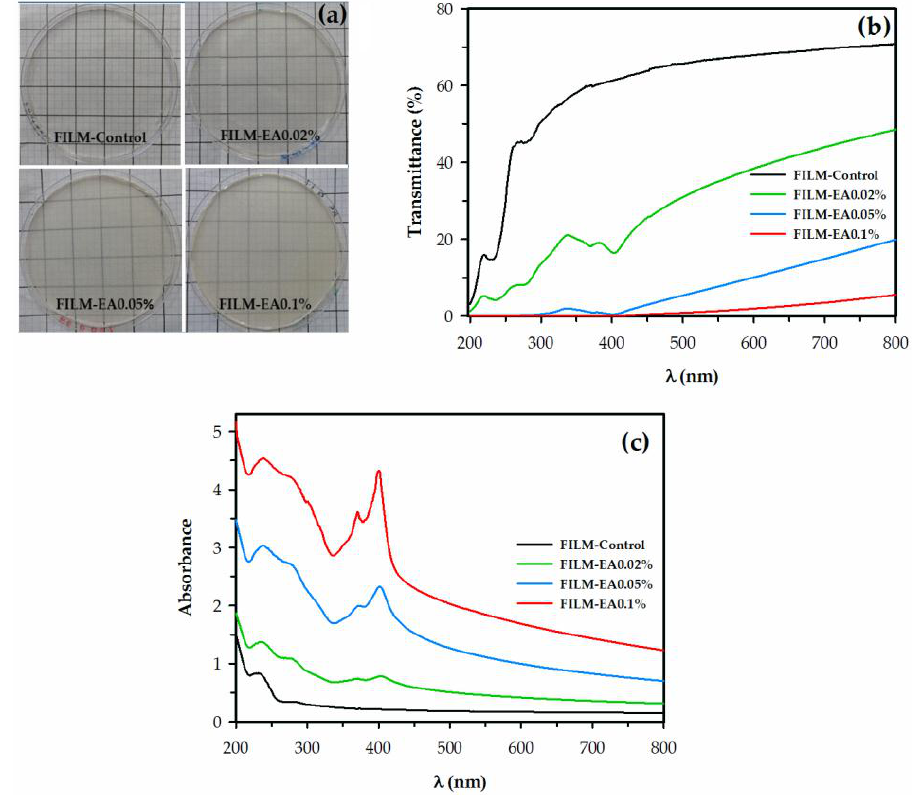
Figure 2. ( a ) Digital images, ( b ) UV-vis transmittance and ( c ) UV-vis absorbance spectra of apple starch films without ellagic acid (FILM-Control) and with ellagic acid (EA) added to 0.02% (FILM-EA0.02%), 0.05% (FILM-EA0.05%) and 0.1% (FILM-EA0.1%).